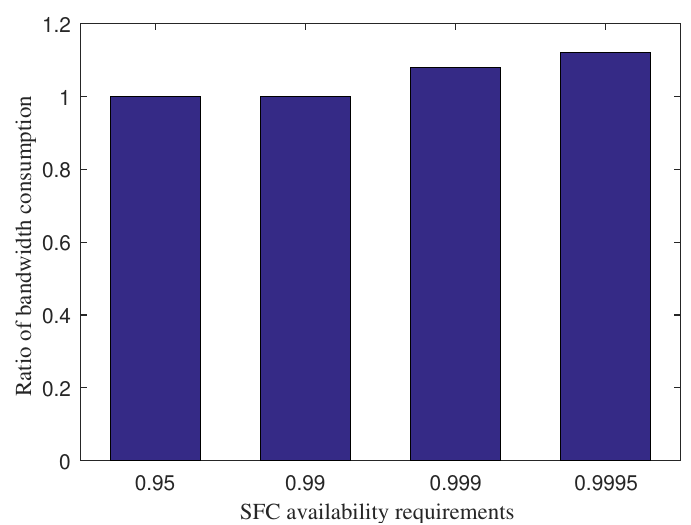
Figure 6. The ratio between of the bandwidth consumption of IPS and IPS without the collaborative scheme under various SFC availability